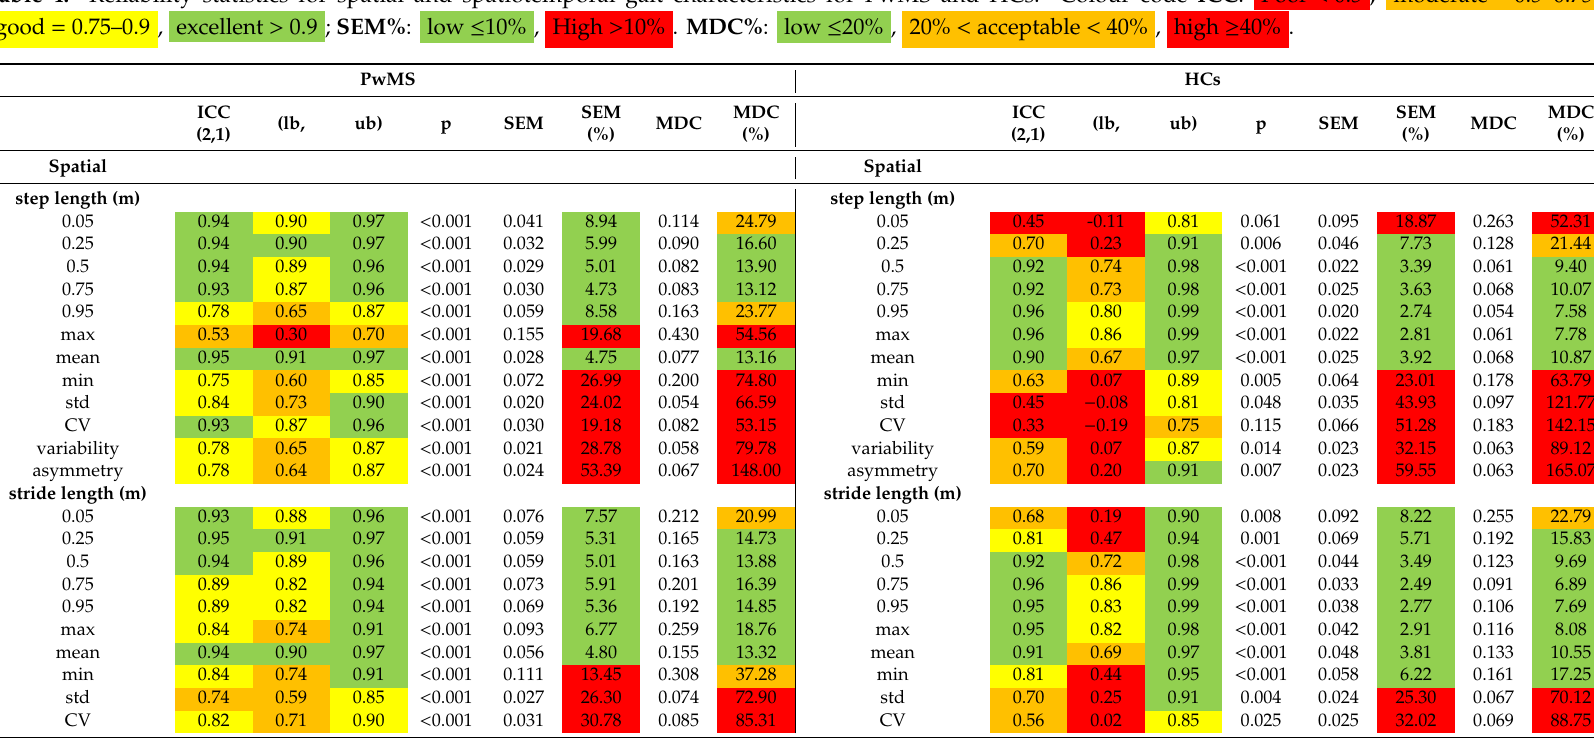
Table 4. Reliability statistics for spatial and spatiotemporal gait characteristics for PwMS and HCs. Colour code ICC : Poor < 0.5 , moderate = 0.5–0.75